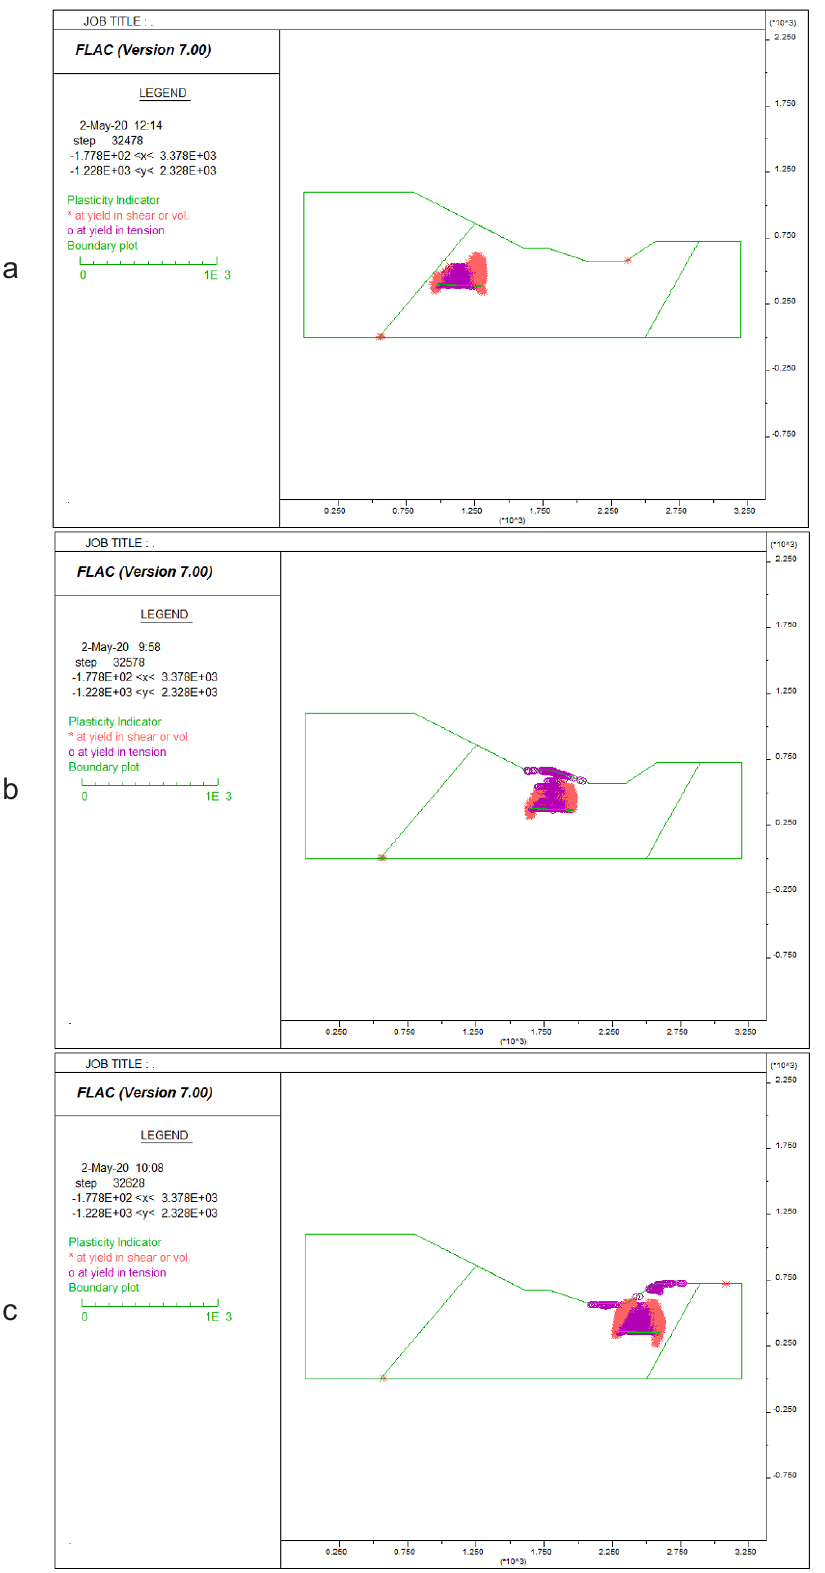
Figure 8: Failure zone induced by UG operation by 2025: (a) scenario I, (b) scenario II, (c) scenario